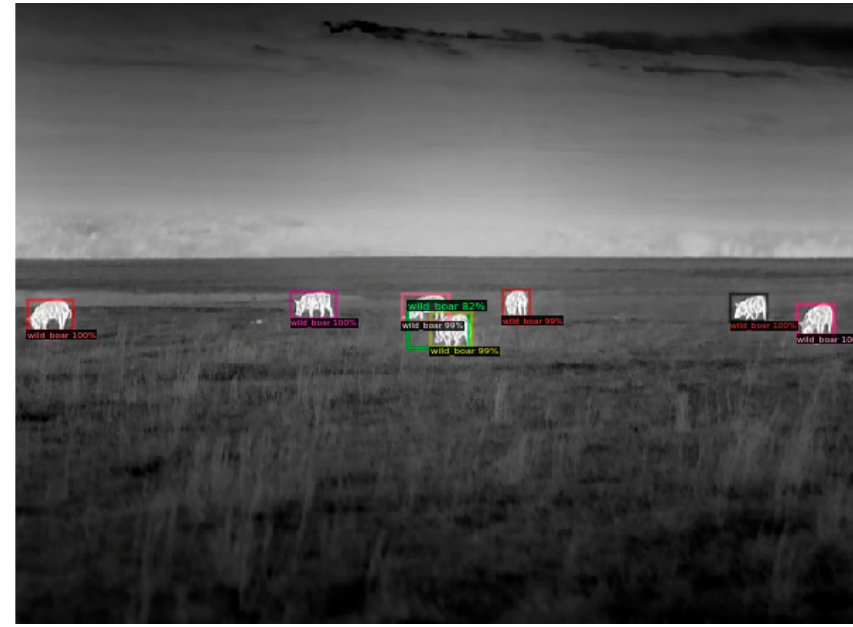
Figure 5. Detection result for Faster R-CNN with the specified probability of the given